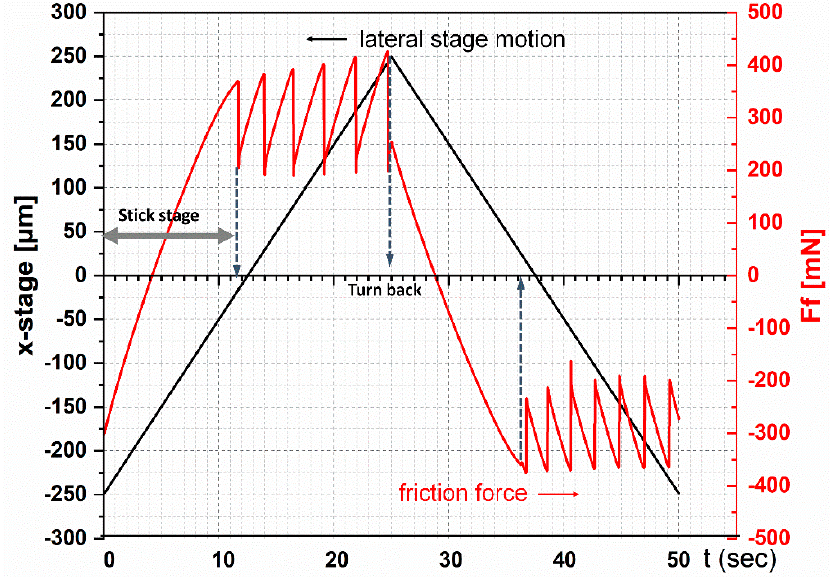
Figure 4. Input displacement of glass countersurface (black) and resulting friction force (red) during the test at a sliding speed of 20 µm/s.